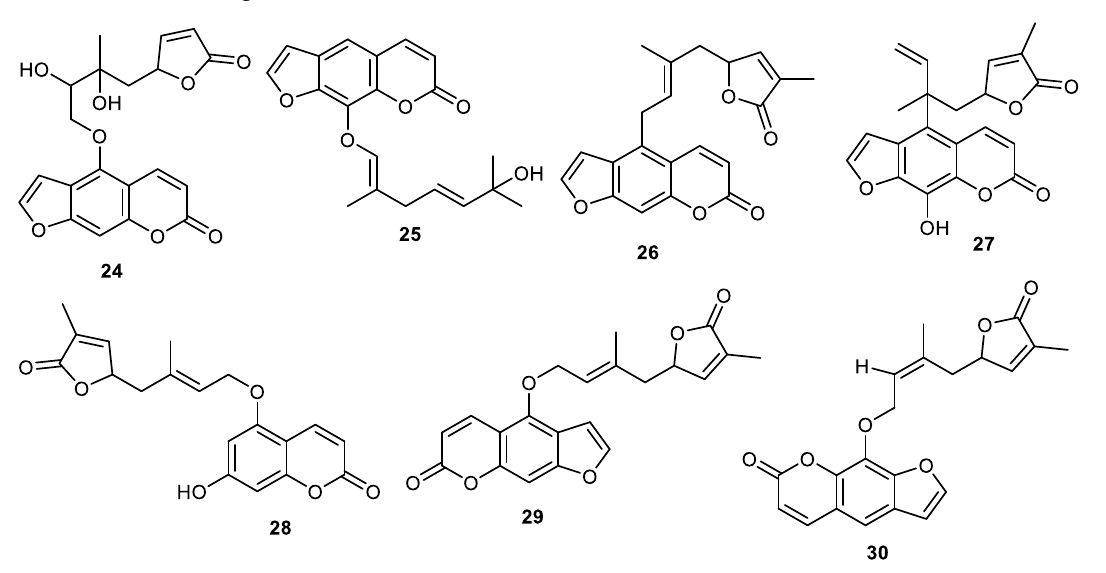
Figure 2. Structures of coumarins 10 – 23 .